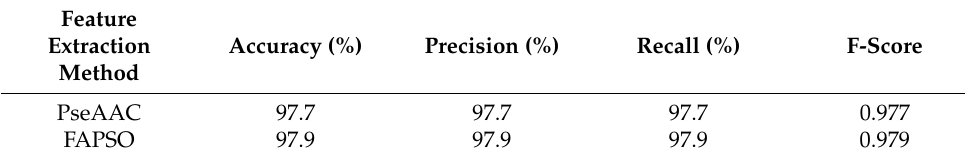
Table 3. GPCR classification performance for family level.